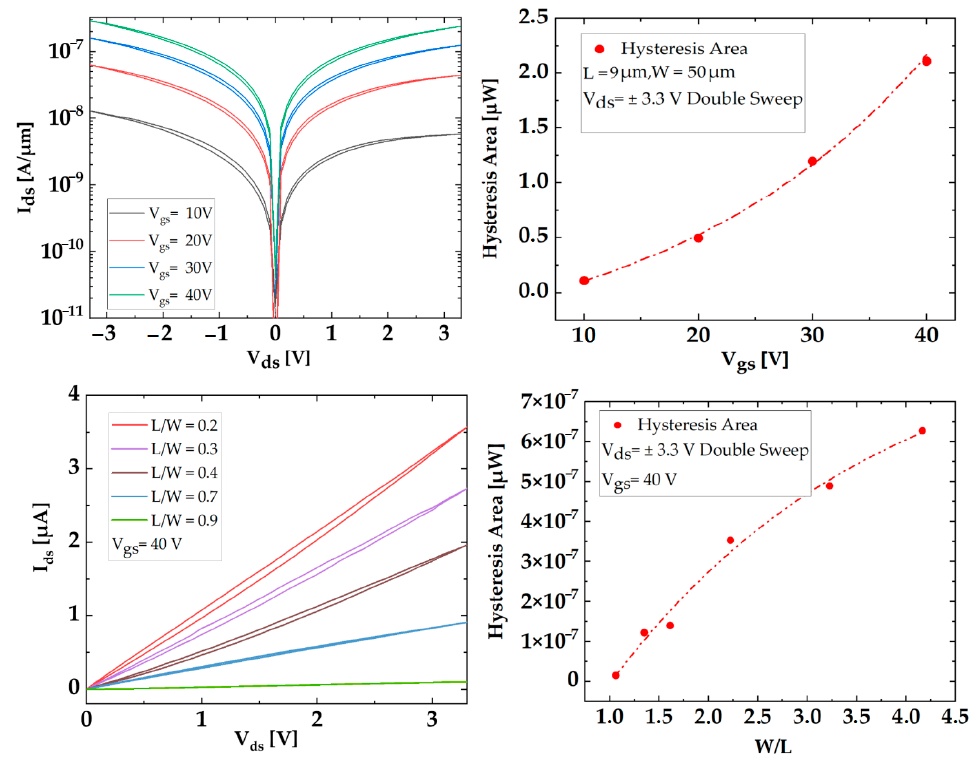
Figure 7. ( a ) Double-sweep output characteristics (logarithmic scale) of MoS 2 FET. ( b ) Dependence of hysteresis area with varying back-gate modulation. ( c ) Double-sweep output characteristics of MoS 2 FET with varying channel length-to-width ratio. ( d ) Hysteresis area dependence with length-to-width ratio of MoS 2 FET.